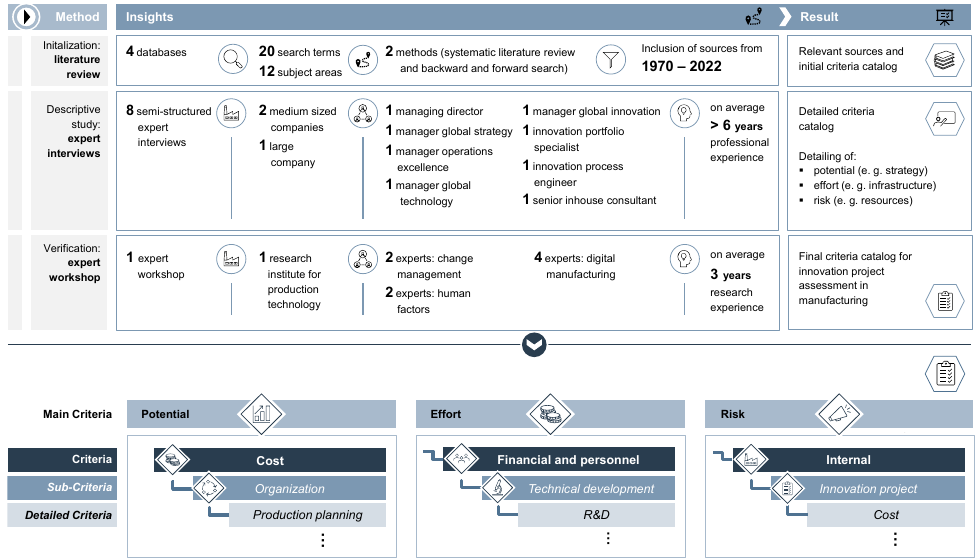
Figure 3. Overview of the methodological derivation of the criteria and schematic structure of the criteria catalog for innovation project assessment.